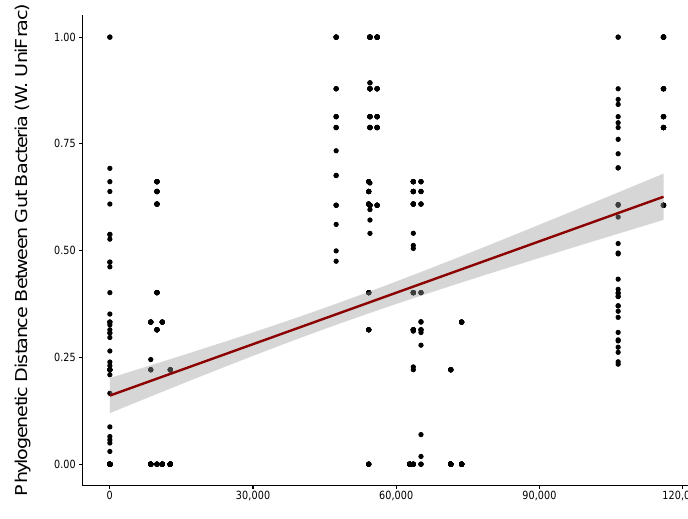
Figure 4. Sphingomonodaceae cladal abundance from north to south geography sampling sites shows a relationship between the phylogenetic composition of the clade and geography. Scatter plot representing a Sphingomonadaceae clade that has a significant correlation between weighted UniFrac and physical straight-line distance between coordinates of sample sites (Mantel test < 0.01). The red line represents the slope of all the data points and shows the positive relationship between geographic distance and phylogenetic distance. The shading represents the 95% confidence interval. This significant trend indicates that sampling sites that are geographically closer together tend to host bacteria with a more similar phylogenetic history. Forty other Sphingomonadaceae clades also display weighted UniFrac values that correlate with geographic distance, and Sphingomonadaceae was the taxon with the most significant clades after this